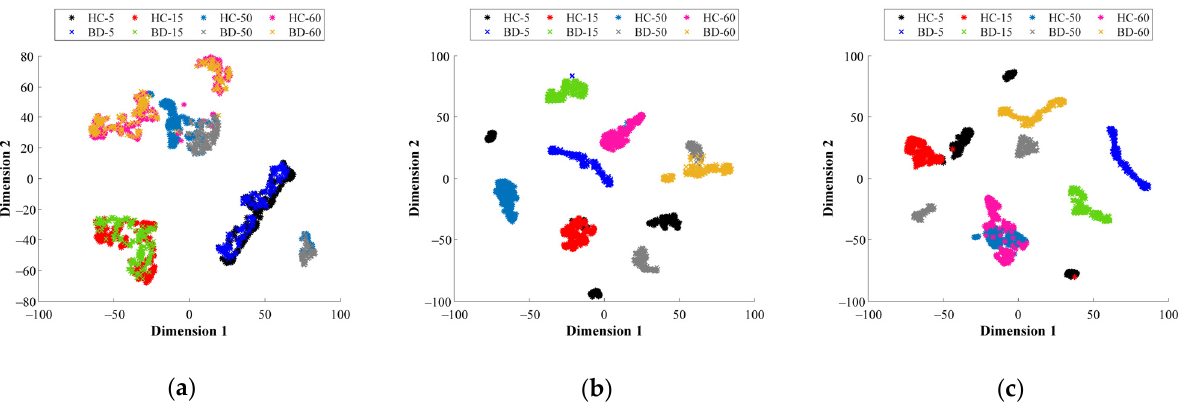
Figure 10. Achieved T-SNE representation of the data distribution into a 2D space of the resulting feature spaces mapped by their corresponding SAE when analyzing the stator current signature in the TD for each different bearing technology: ( a ) metallic, ( b ) hybrid and ( c ) full ceramic.